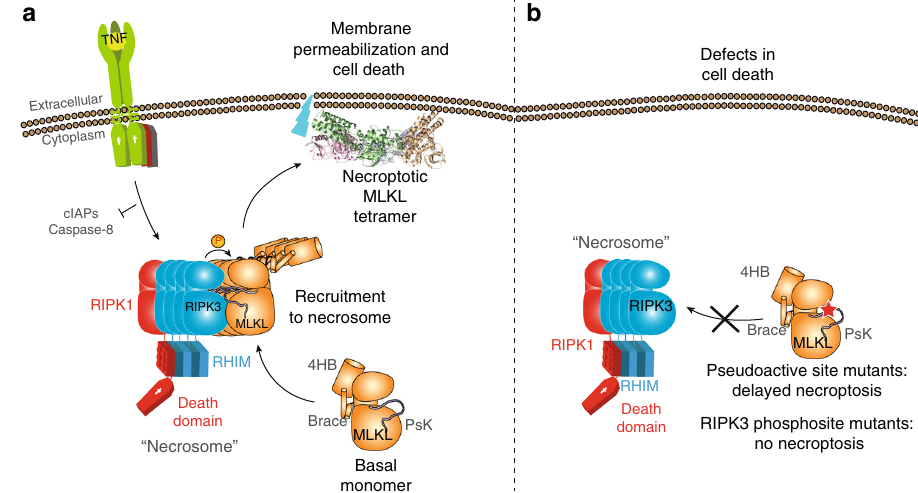
Fig. 5 Mutations in the PsK domain compromise hMLKL-driven necroptosis in cells. a MLKL expression in parental U937, edited MLKL − / − U937, and MLKL − / − U937 cells reconstituted with a doxycycline-inducible wild-type hMLKL construct were assessed by western blot. Loading control: anti-actin reprobe. b Sensitivity of parental U937, edited MLKL − / − U937, and MLKL − / − U937 reconstituted with doxycycline-inducible wild-type hMLKL to apoptotic (TS) and necroptotic (TSI) stimuli was assessed by PI uptake and fl ow cytometry. Data represent mean ± SEM of three independent assays. c Sensitivity of MLKL − / − U937 cells reconstituted with doxycycline-inducible wild-type or mutant hMLKL to necroptotic death assessed at 6, 12, and 24 h post-TSI treatment by PI uptake and fl ow cytometry. Individual data points are plotted as circles. d Parental U937 and MLKL − / − U937 reconstituted with wild-type hMLKL or the E351K, E258K, T357E/S358E, E258K/E351K, or D107A/E111A mutants were assessed for oligomer formation by Blue Native PAGE post-TSI treatment at the indicated time points. Separation into cytoplasmic (C) and membrane (M) fraction was validated by SDS-PAGE western blots for VDAC1 (membrane) and GAPDH (cytoplasmic). All blots are representative of ≥ 2 independent experiments. e Sensitivity of MLKL − / − U937 cells reconstituted with doxycycline-inducible wild-type or mutant T357E/S358E, T357E/S358D, T357A/S358A, T357E/S358E/E351K, T357A, T357D, S358A, and S358E hMLKL to necroptotic death assessed at 6, 12, and 24 h post-TSI treatment by PI uptake and fl ow cytometry. Data in c and e represent mean±SEM of two independent assays of duplicate cell lines, except for T357E/S358D, which represents mean ± SD of two independent assays on a single line. Individual data points are plotted as circles. f Sensitivity of parental HT29, MLKL − / − HT29, and MLKL − / − HT29 cells reconstituted with doxycycline-inducible wild- type or mutant T357E/S358E, T357E/S358D hMLKL to necroptotic death at 48 h post-TSI treatment. Data represent mean±SEM of two independent assays on 4 (wild-type) or 2 (mutant) cell lines. Data for parental HT29 cells from a single experiment are shown for comparison. Individual data points are plotted as circles. g Streptavidin-binding peptide (SBP)-tagged hRIPK3 kinase domain immobilized on a streptavidin chip showed robust binding to wild- type, but not T357E/S358E, hMLKL (analyte applied over 0 – 1 μ M) by surface plasmon resonance. Data are representative of four independent